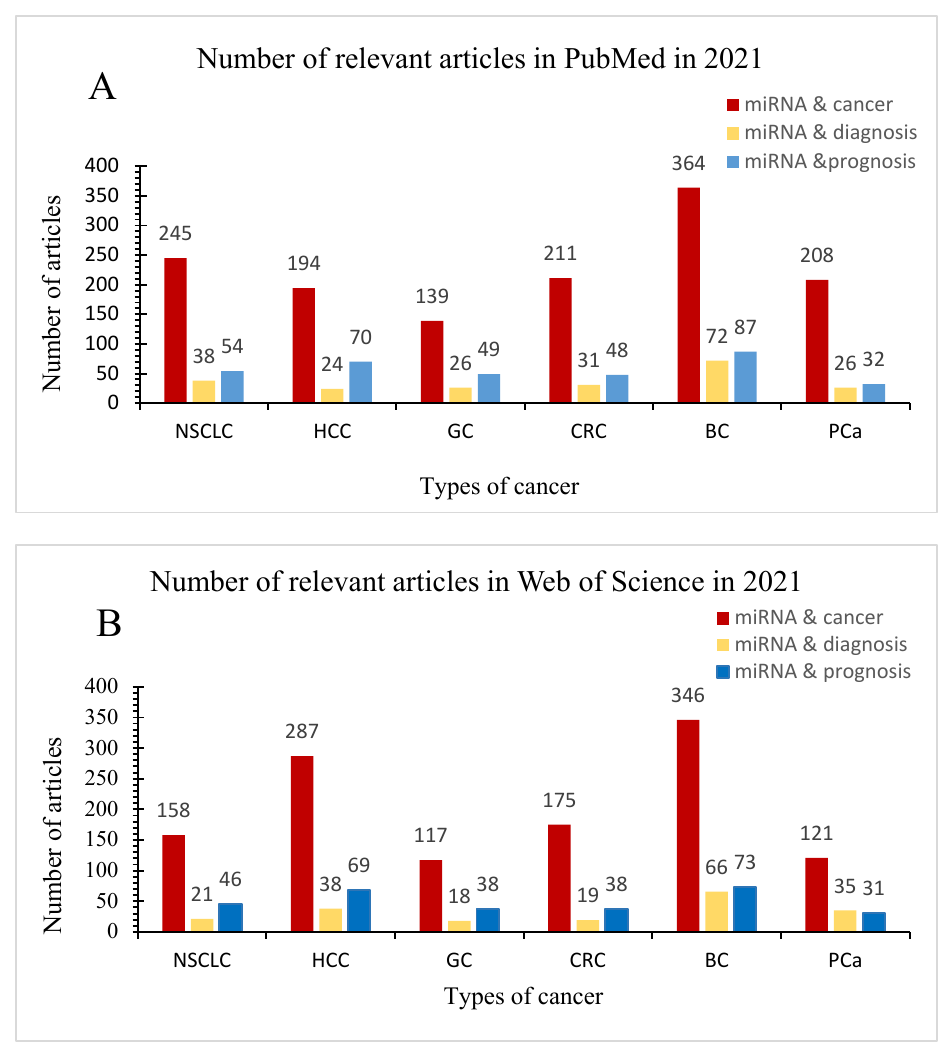
Figure 3. Articles on the diagnosis and prognosis of miRNAs in six cancers in 2021. ( A ) Number of relevant articles in PubMed in 2021. ( B ) Number of relevant articles in web of Science in 2021.